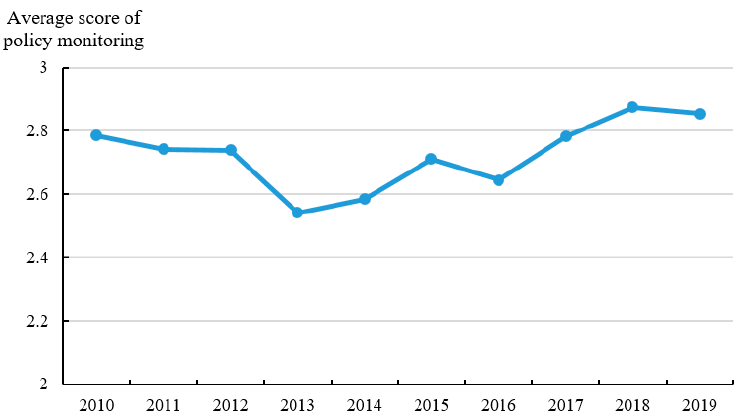
Figure 7. Average score of policy monitoring from 2010 to 2019.